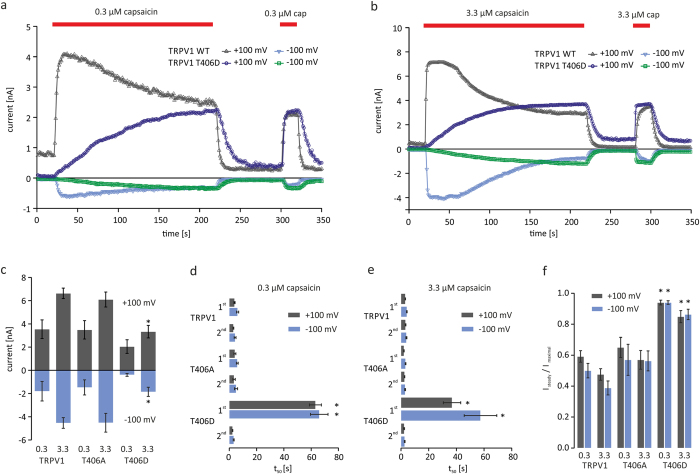
TRPV1T406D mutants show slowed activation kinetics.Ca2+-induced desensitization of TRPV1WT and TRPV1T406 mutants in transiently transfected CHO cells challenged with 0.3 μM or 3.3 μM capsaicin measured by voltage ramp protocols in the presence of extracellular Ca2+. Application of 0.3 μM (a) or 3.3 μM (b) capsaicin for 200 s induces TRPV1-mediated currents. Amplitudes of capsaicin-induced currents (c), activation kinetics represented by time to half maximum current (t50) of first and second response to 0.3 μM (d) or 3.3 μM capsaicin (e). Desensitization represented as ratio (Isteady/Imaximal) of n = 8–13 independent measurements (f). Asterisk (*) indicates significant differences compared to the corresponding TRPV1WT value (unpaired WR-test, p < 0.05).